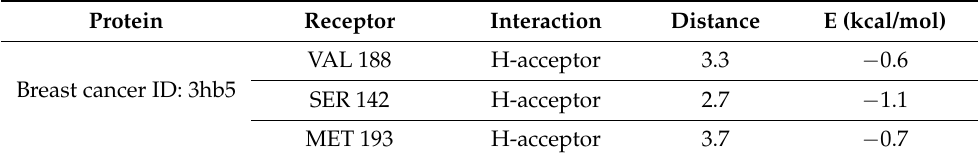
Table 10. Binding energy of the interaction with Pt complex.